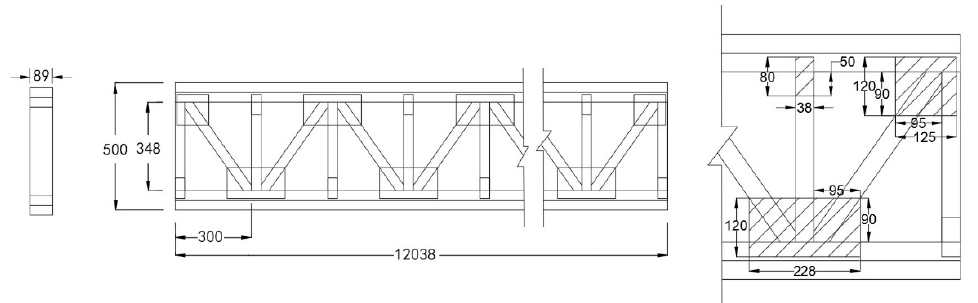
Figure 1. Construction of test floor.